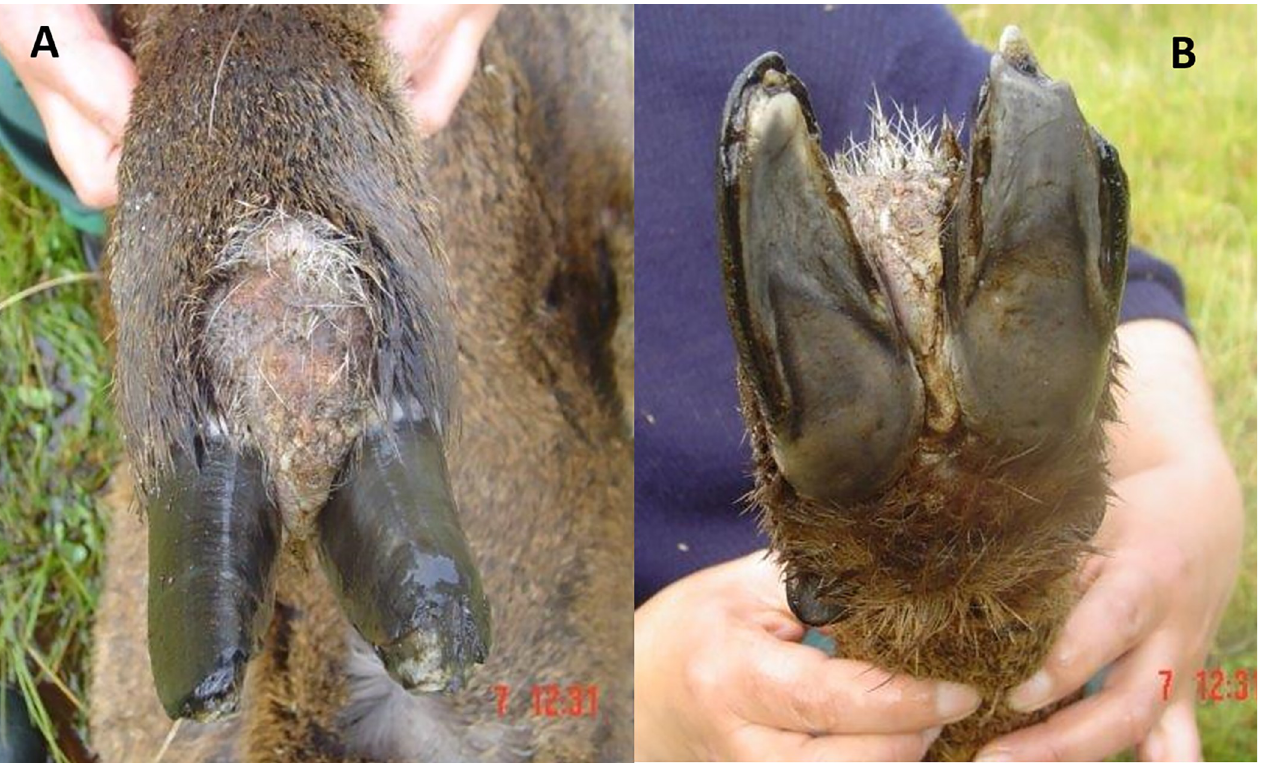
Fig 3. Affected foot (post mortem) of adult female huemul (Case #1, Table 1). A) Dorsal aspect of the right foreleg. A large, roughly round area of soft tissue swelling is present in the interdigital space and immediately proximal and adjacent haired skin, which is focally alopecic. B) Ventral aspect of the right foreleg. The skin is discolored red and gray. Soft tissue swelling has caused moderate separation of the claws, the tips of which are irregularly and abnormally worn.